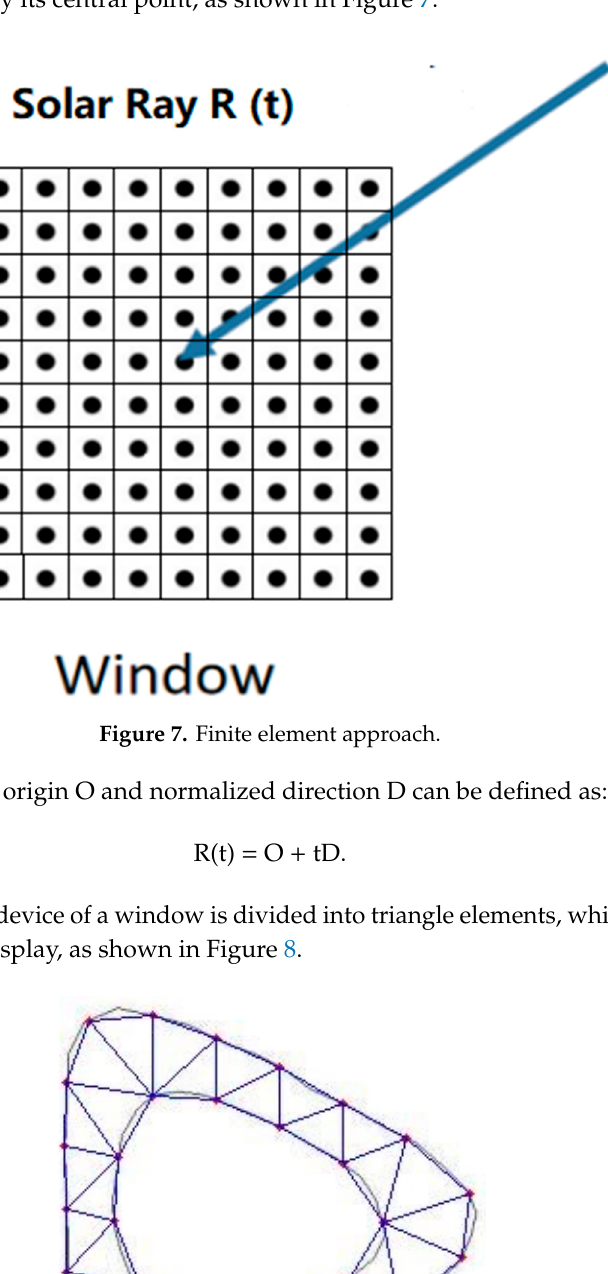
Figure 6. Solar geometry.